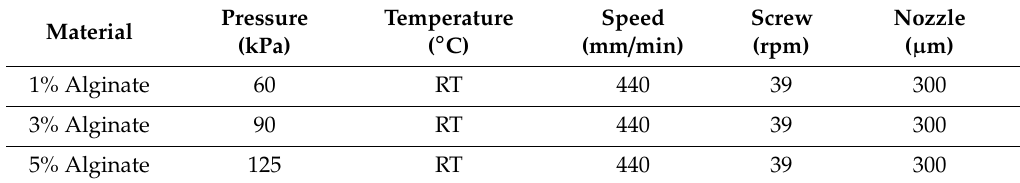
Table 1. Fabrication processes for the conditions of 1%, 3%, and 5%